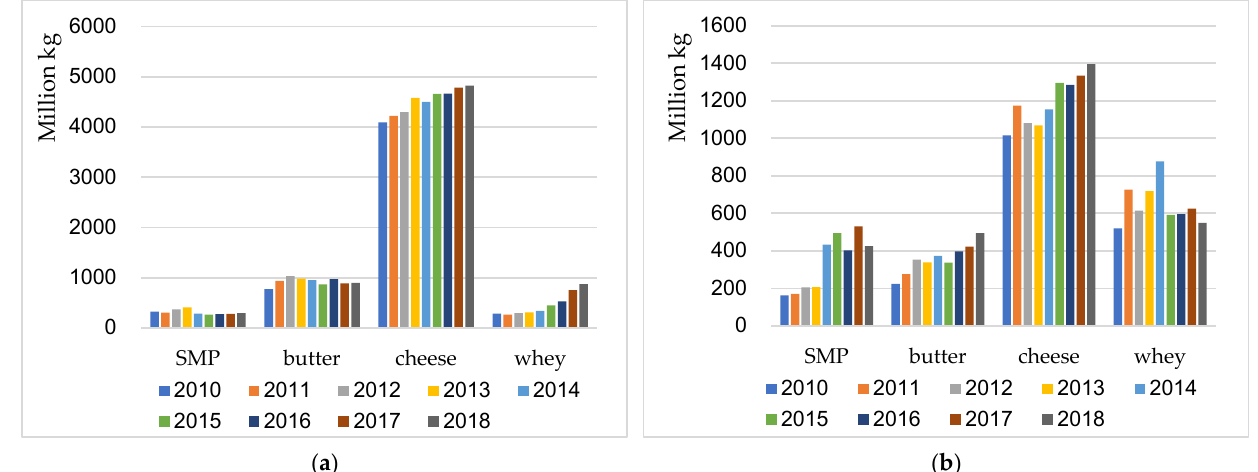
Figure 2. The bilateral export in quantity of major dairy products between EU-27 and the UK. (Source: authors’ depiction using data downloaded from Eurostat database, accessed on 6 September 2019). ( a ) EU-27 export quantity of major dairy products on the UK market. ( b ) UK export quantity of major dairy products on the EU-27 market.